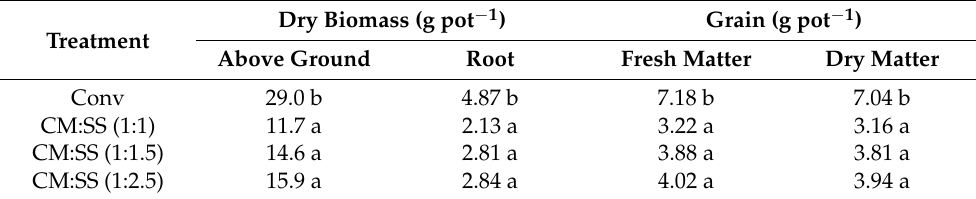
Figure 6. Plant height ( a ), chlorophyll content ( b ), number of tillers ( c ) in each treatment during the pot experiment. All values are expressed as mean. Conv: conventional, CM: chicken manure, SS: steel slag, SF: supplementary fertilization, D: the time when the pot was dried. Error bars represent standard error. Table 4. Dry biomass and grain yield after harvest in the pot